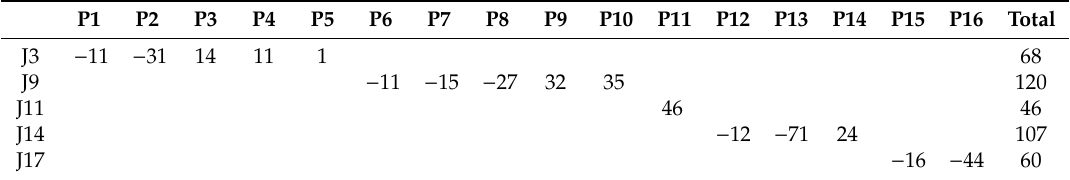
Table 3. Drainage time of pipes through an assigned major washout